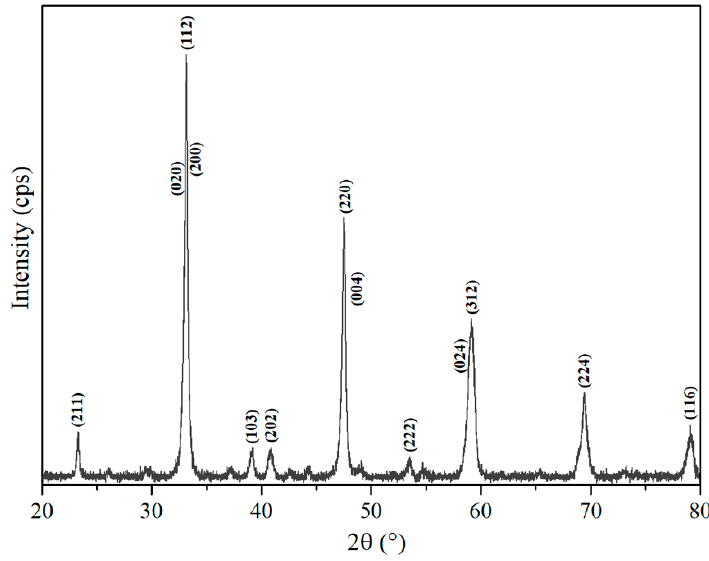
Figure 3. XRD pattern of CTO calcined powders.